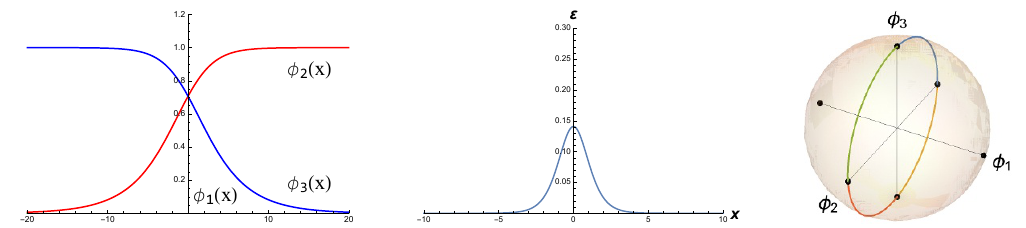
Figure 2 . Pro(cid:12)le of the Cartesian (cid:12)eld components (left), wall tension density (middle) and orbits for the K ( q;b;c ) ( x ) domain walls 1